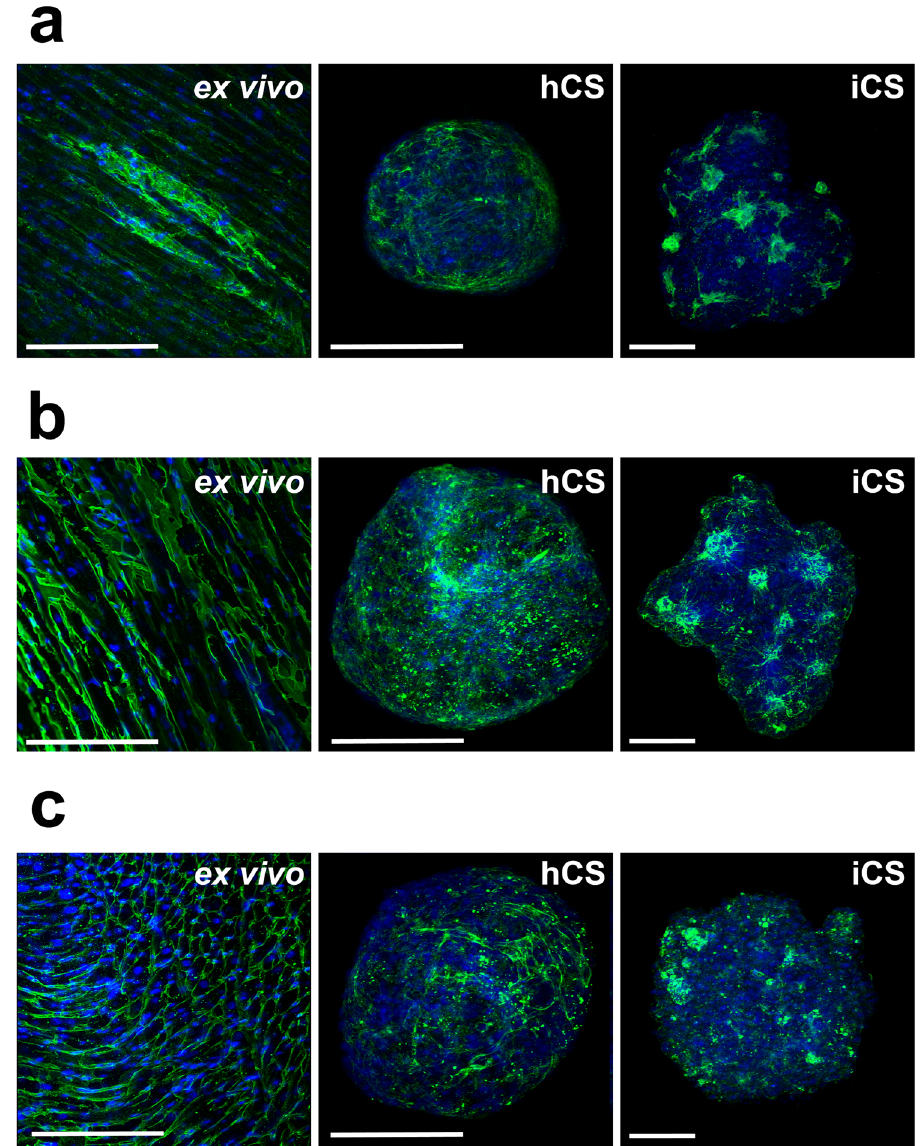
Figure 3. Extracellular matrix (ECM) deposition ex vivo and in vitro . Fibronectin ( a ), collagen type IV ( b ) and laminin ( c ) deposition within human heart sections, hCSs and iCSs (green). Nuclei are stained with Hoechst stain (blue). Scale bars: 200 μ